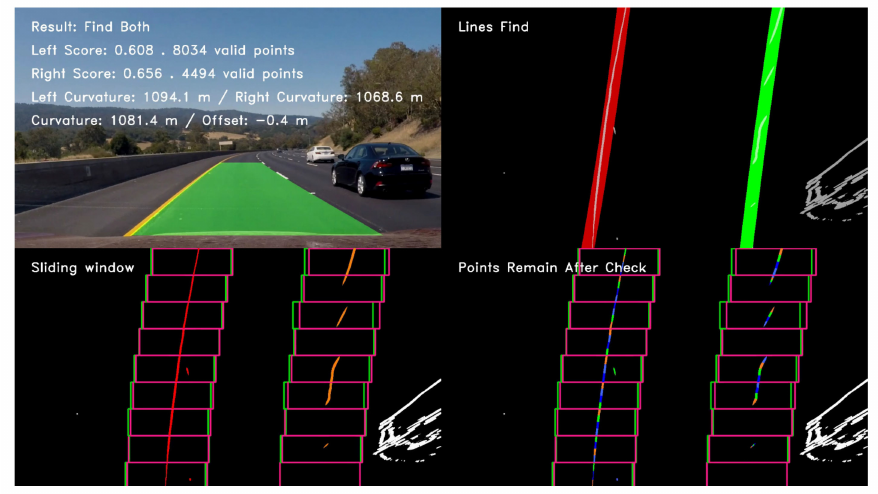
Figure 12. The test result of a typical detected frame in the highway driving video.